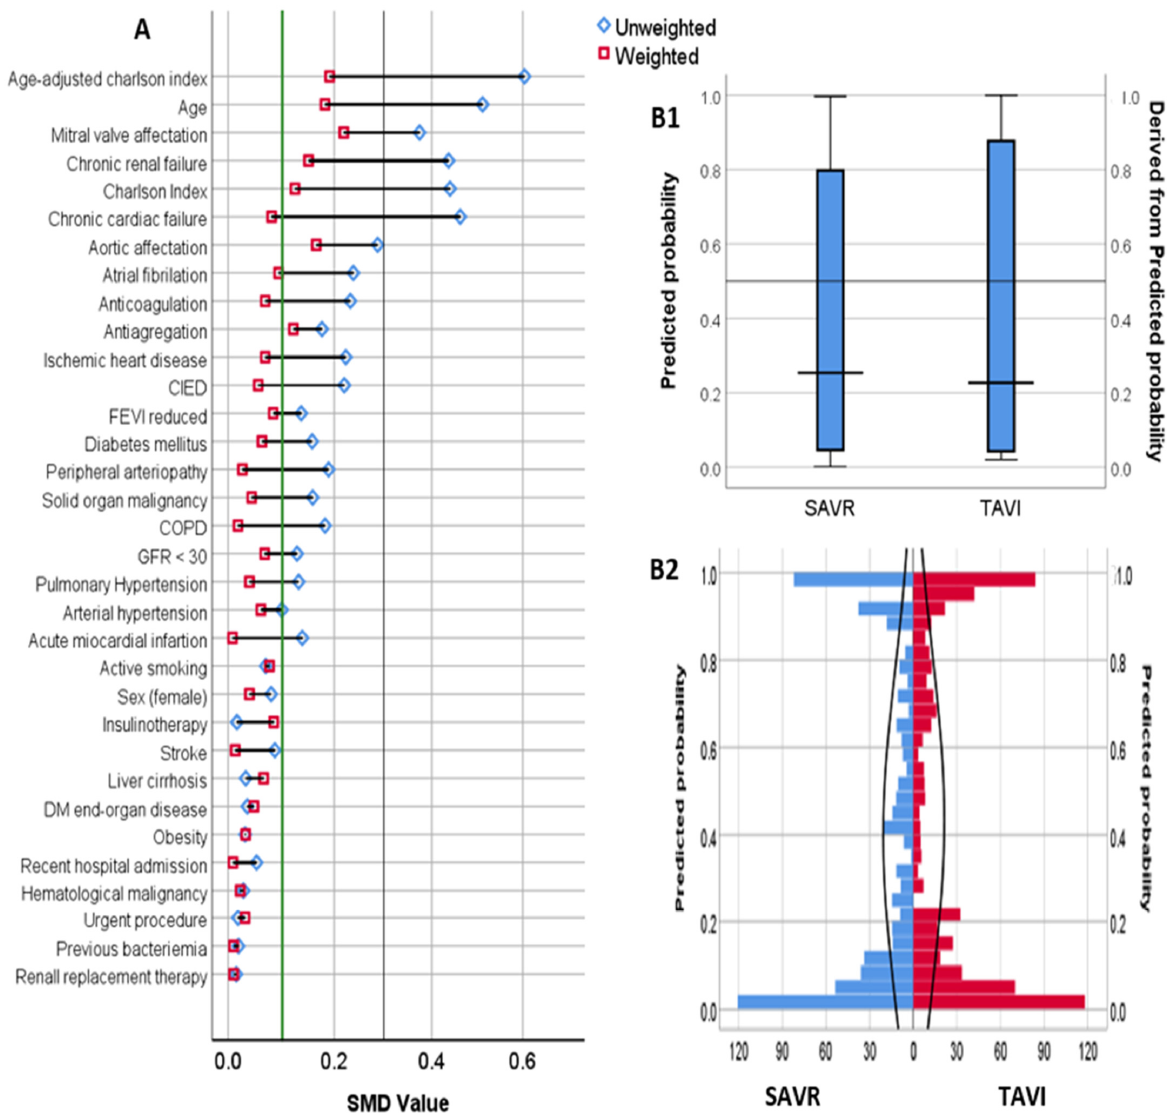
Figure 2. Covariates and propensity score distribution among IPTW cohort. ( A ): Standardized mean difference (SMD) among baseline covariates. Green line represents SMD of 10%. Blue dot represents the SMD value in the unweighted cohort. Red dot represents the value in the Inverse Probability of Treatment Weighted cohort. B: Propensity score of TAVI numeric ( B1 ) and absolute ( B2 ) distribution among patients with TAVI and SAVR in the IPTW cohort.